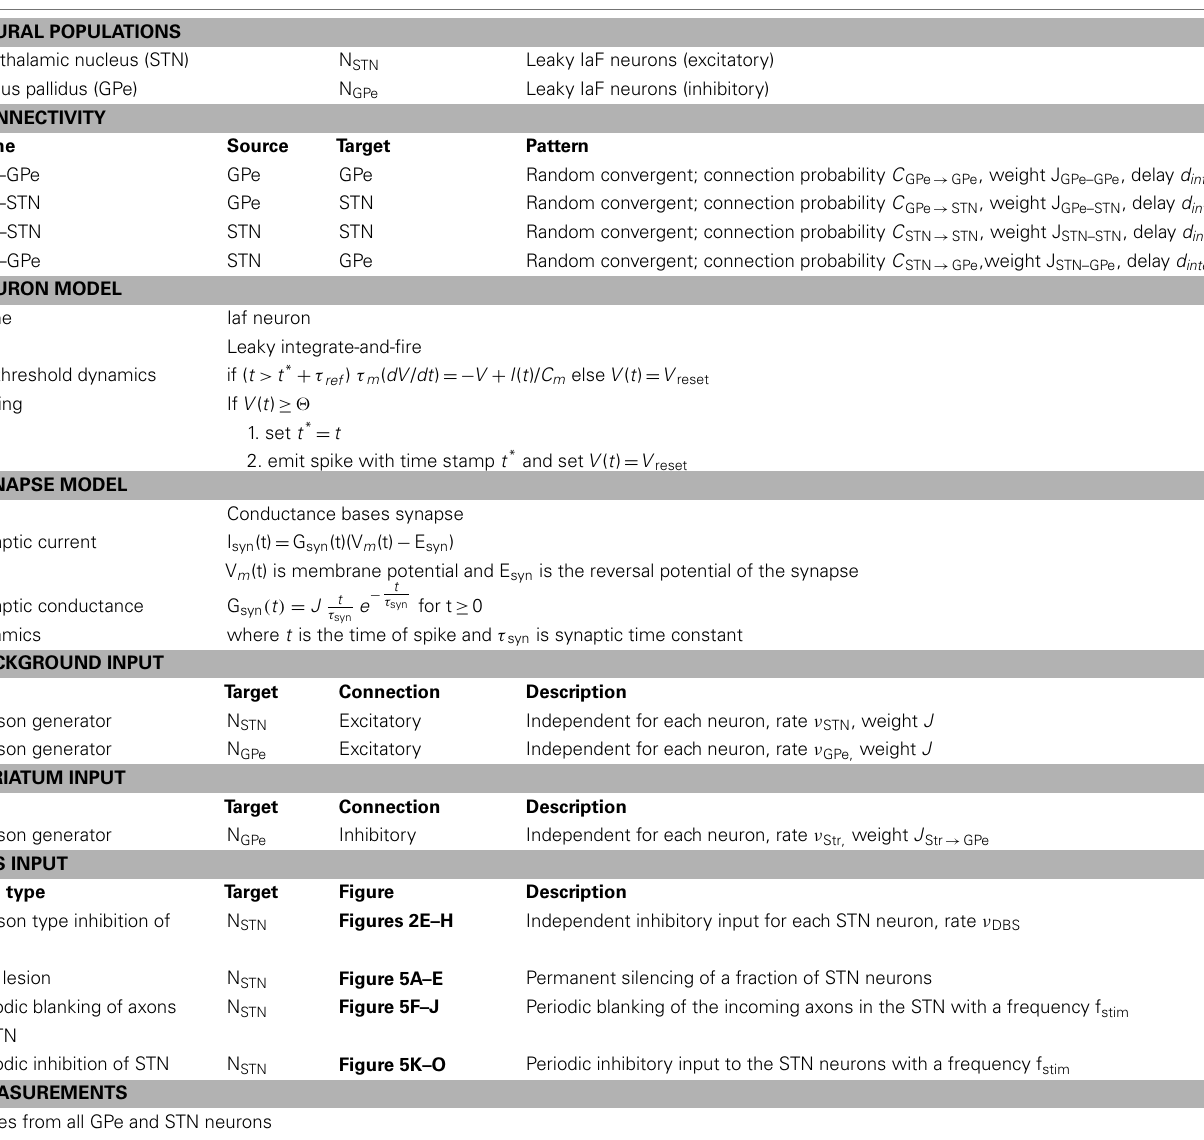
Figure 5A–E Permanent silencing of a fraction of STN neurons Figure 5F–J Periodic blanking of the incoming axons in the STN with a frequency f stim Figure